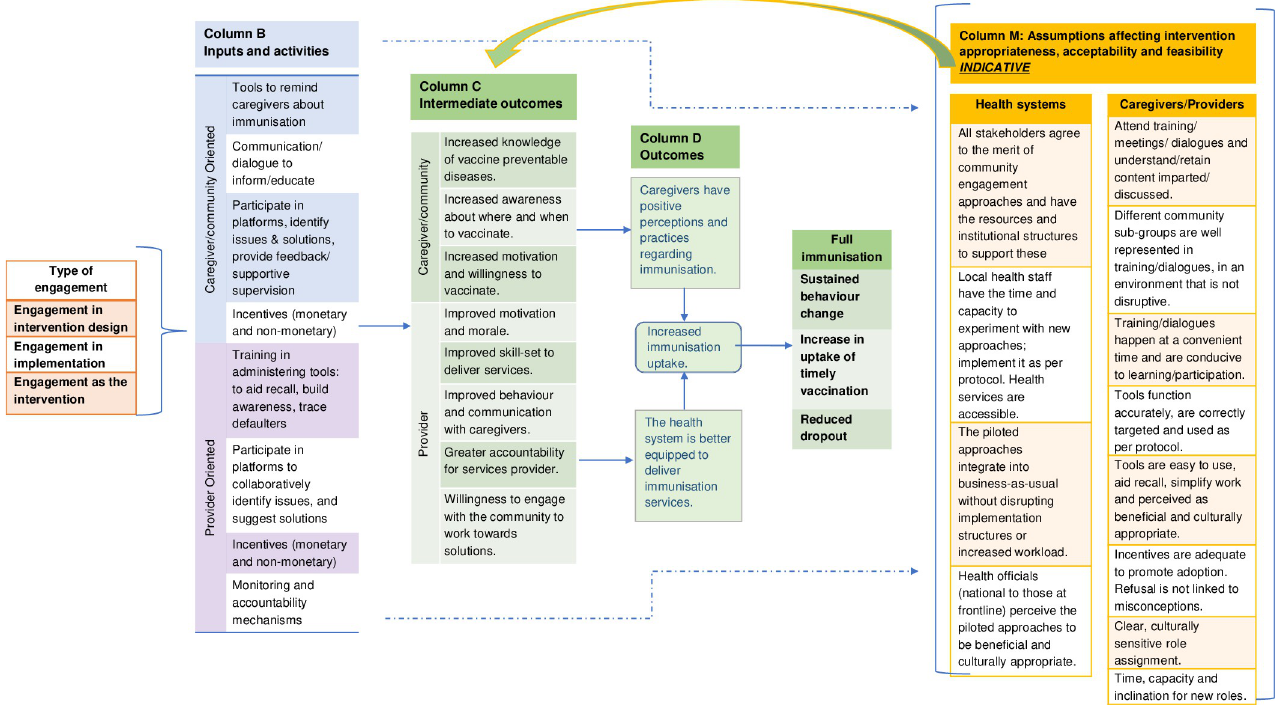
Fig 1. Theory of change for community engagement-based interventions in immunisation. Adapted from [17].